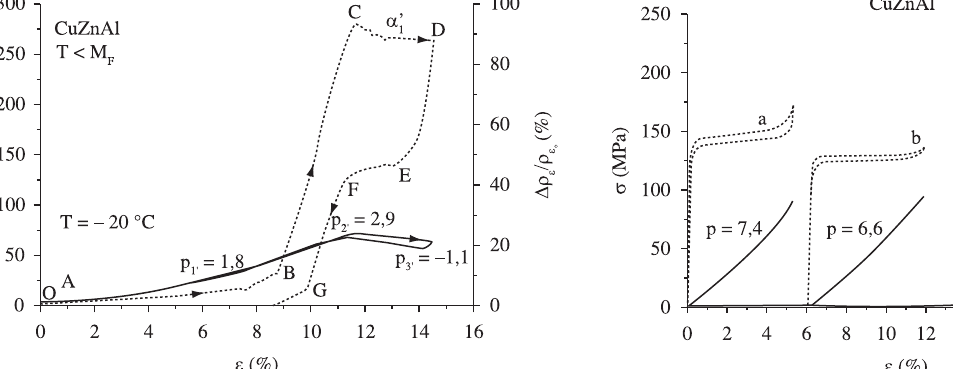
Figure 6. Superelastic tests in the CZA10 tensile samples with different crystallographic orientations (Cu-Zn-Al alloy).